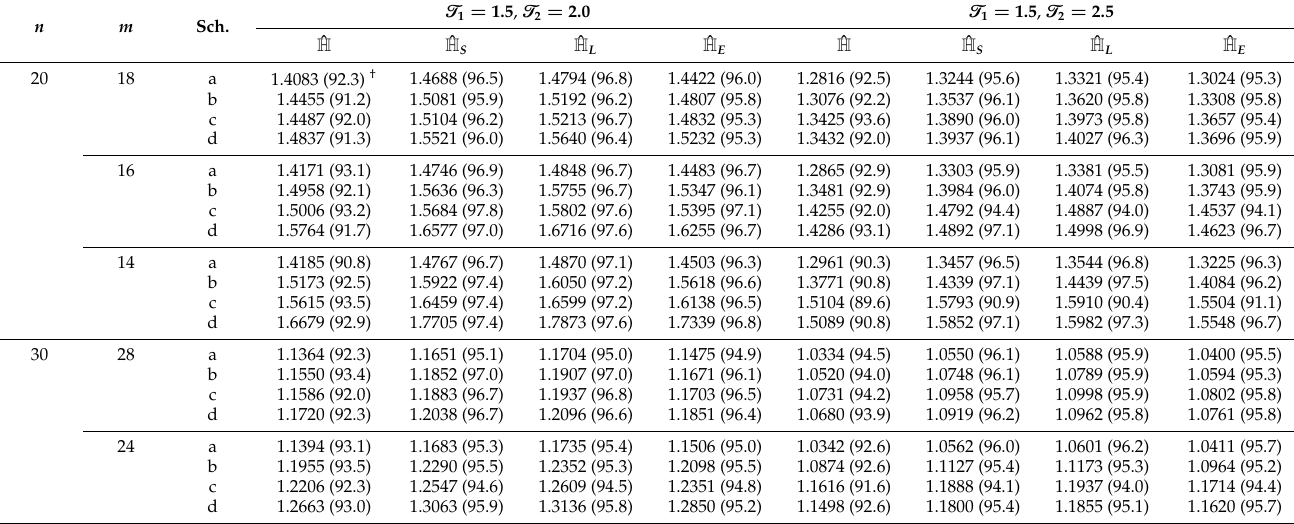
Table 4. The relative CLs and CPs of entropy estimators with classical and